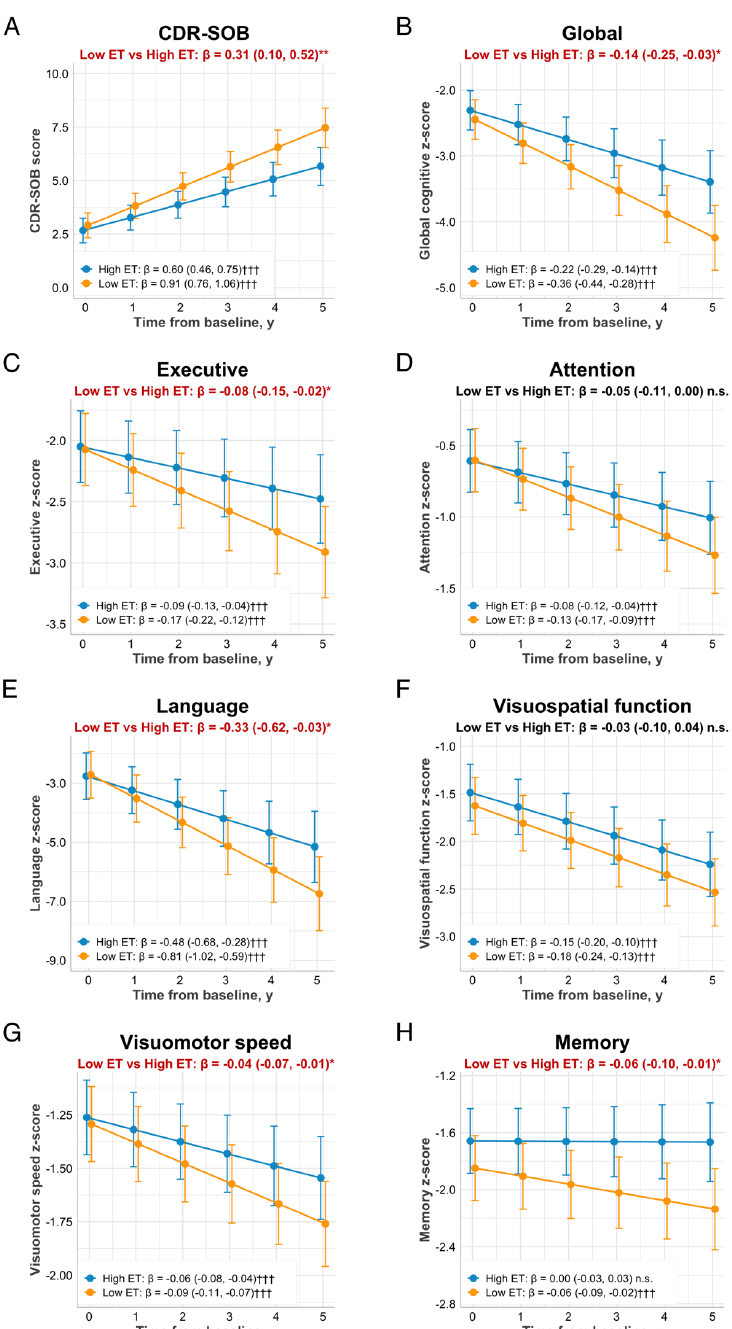
Figure 2. Trajectories of cognitive and functional decline in relation to baseline plasma ET status. Estimated means of CDR-SOB scores ( A ) and global/domain-specific cognitive z-scores ( B – H ) with 95% CI are presented for those with high baseline ET (above group median; blue lines) and low baseline ET (below group median; orange lines). β -coefficients (95% CI) were derived from linear mixed-effect models adjusted for age, gender, education, APOE ε 4 status, hypertension, diabetes, cardiovascular disease, and baseline MMSE. * and ** (in red text) indicate significantly different rates of change in cognitive scores between low ET vs. high ET patients at p < 0.05 and p < 0.01, respectively. ††† indicates a significant increase in CDR-SOB or a significant decline in cognitive z-scores over time (slope) at p < 0.001. Abbreviations: CDR-SOB = Clinical Dementia Rating Sum- of-Boxes, CI = confidence interval, ET = ergothioneine; MMSE = Mini-Mental State Examination, n.s. = not